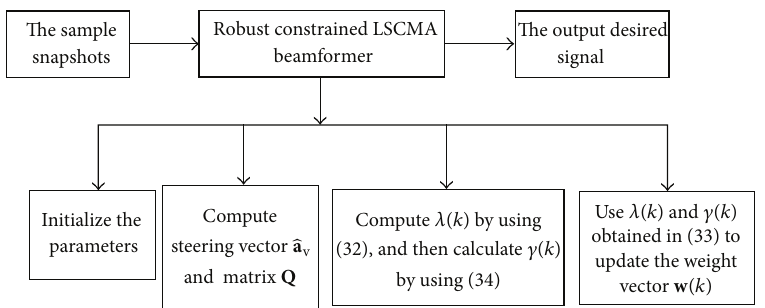
Figure 1: The simulation scenario diagram.